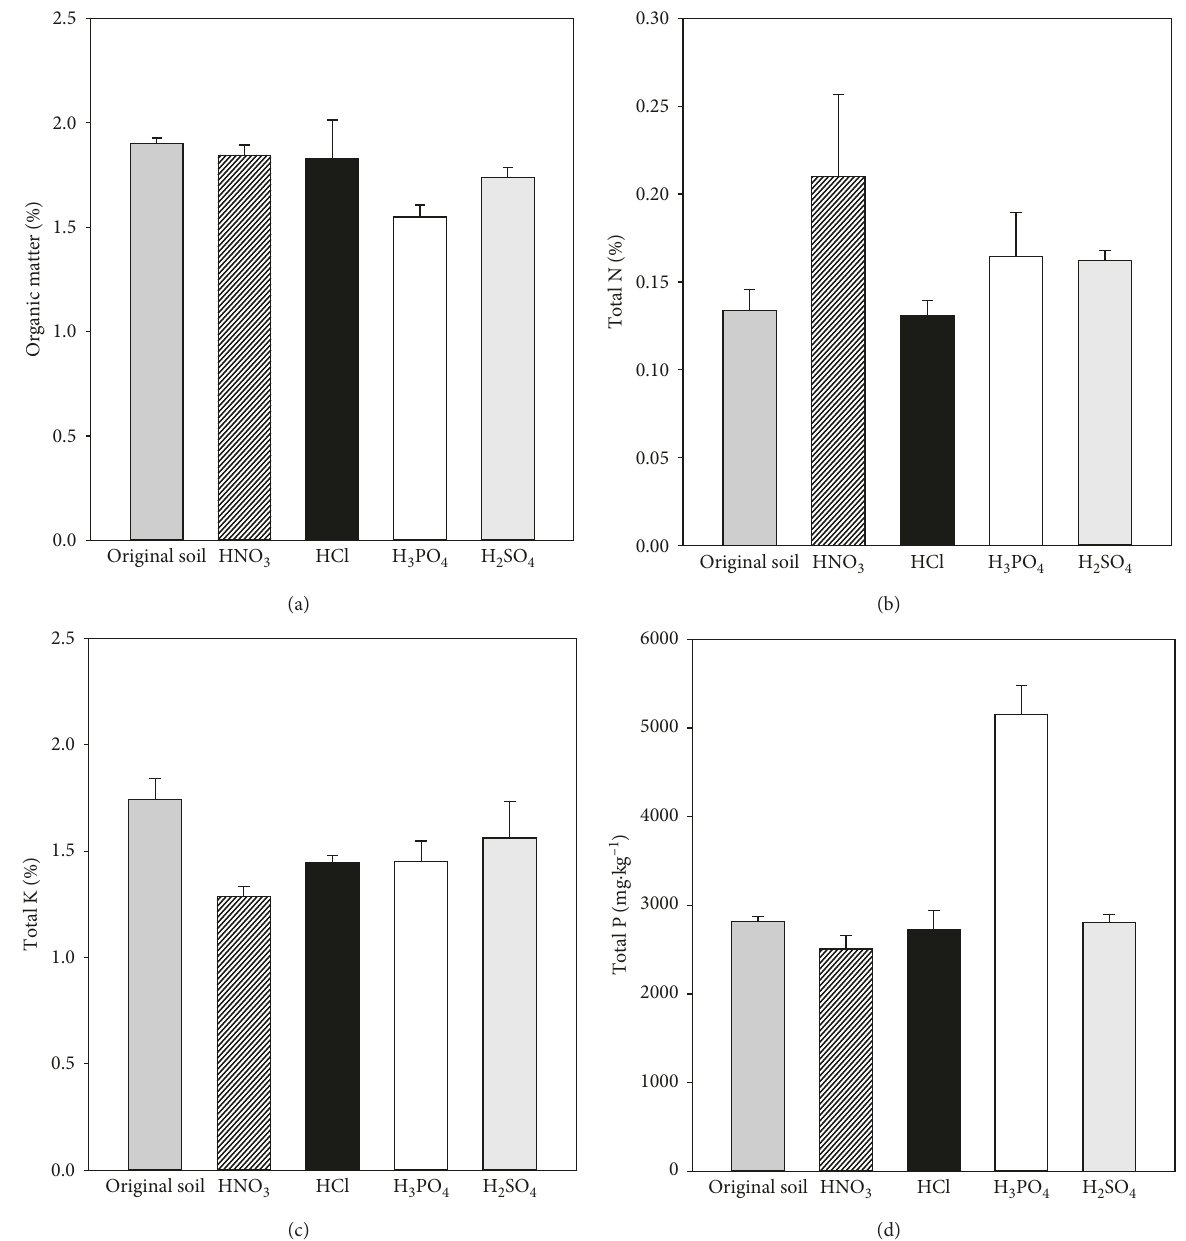
Figure 3: The changes in content of (a) organic matter, (b) total N, (c) total K, and (d) total P after leaching by various acid